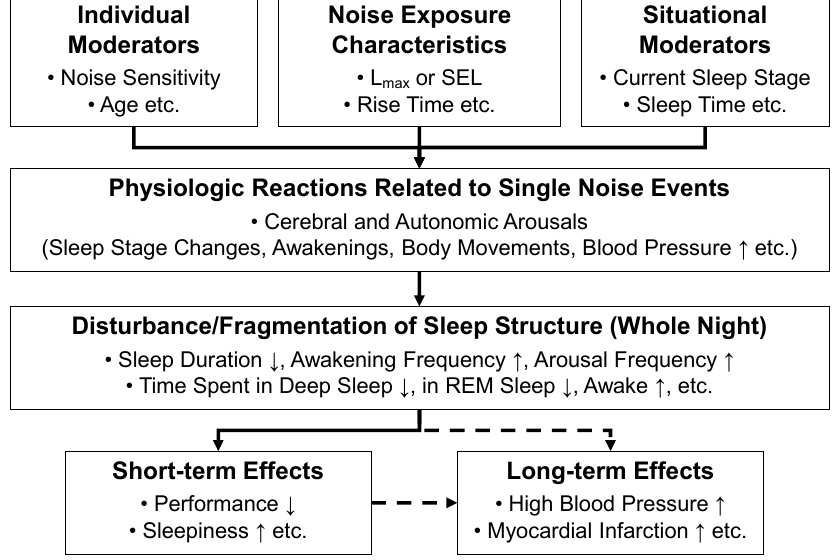
Figure 1. Effects of noise on sleep. It is hypothesized that health consequences will develop if sleep is relevantly disturbed by noise over long time periods (dashed lines; figure reproduced from Basner et al. [25]).